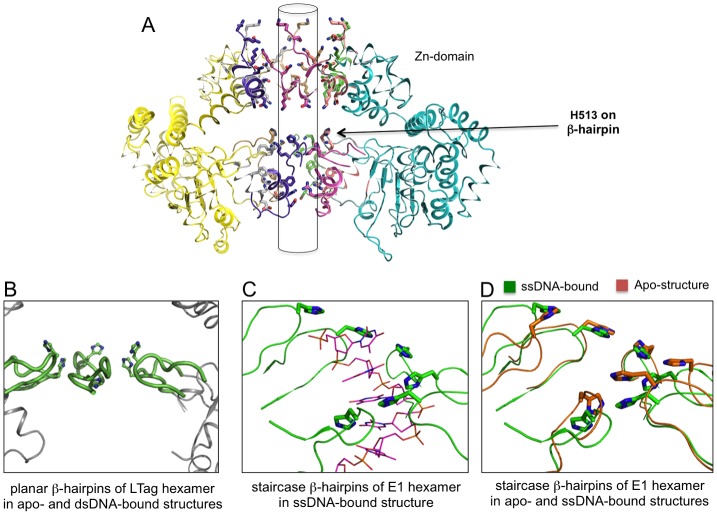
The planar and staircase arrangements of β-hairpins in the hexamer structures of LT and E1.(A) The near-planar arrangement of the six β-hairpins (indicated by an arrow) in the hexamer channel of LT. Such near-planar arrangement is maintained in all the structures of LT hexamer determined to date, regardless of their dsDNA-bound or DNA-free states. (B) A close-up view of the near-planar arrangement of the six LT β-hairpins from (A), with H513 on the β-hairpin tip shown in sticks. The close-up view reveals that the six H513 and β-hairpins have no real six-fold symmetry. However, a near-planar arrangement is obvious when compared with the staircase arrangement shown in (C). (C) The staircase arrangement of the six β-hairpins (and the tip His residue) in the E1 hexameric channel, showing a six-nucleotide ssDNA (in thin sticks) with each of the six nucleotides havingsimilar interactions with the six β-hairpins (PDBid: 2GXA). (D) Alignment of the β-hairpins in the central channel of E1 hexamer structures in the ssDNA-bound state (PDBid: 2GXA, in green) and the DNA-free state (PDBid: 2V9P, in orange), showing the same staircase arrangement for the β-hairpins, regardless of ssDNA-bound or ssDNA-free state.